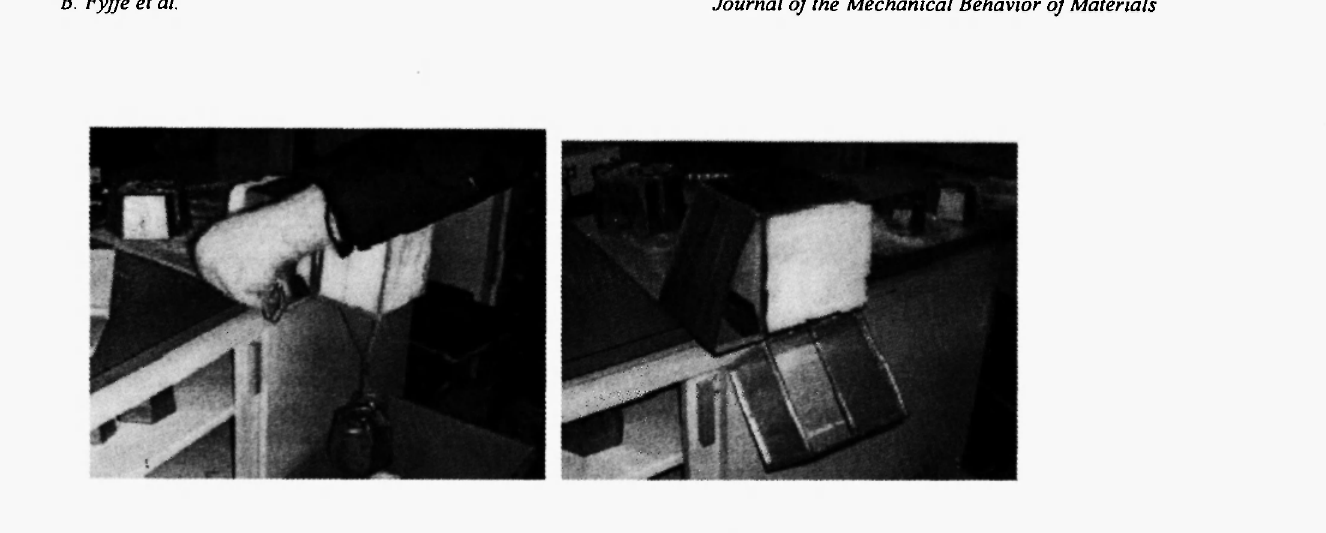
Fig. 3: The mode I experiment. Left: cutting through the snow block at the gap between the box sections with a wire. Right: the device and fracture surface after failure. Although not apparent in this image, the fracture surface is rough and easily distinguishable from the surface caused by the cutting with the